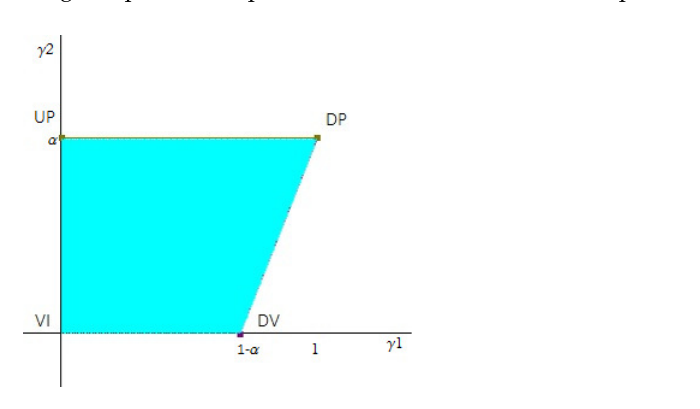
Figure 1. Graphical representation of the parametric family of auction mechanisms for two objects with α 1 = 1 and α 2 = 0.3. Each vertex correspond to a combination of the parameters γ 1 and γ 2